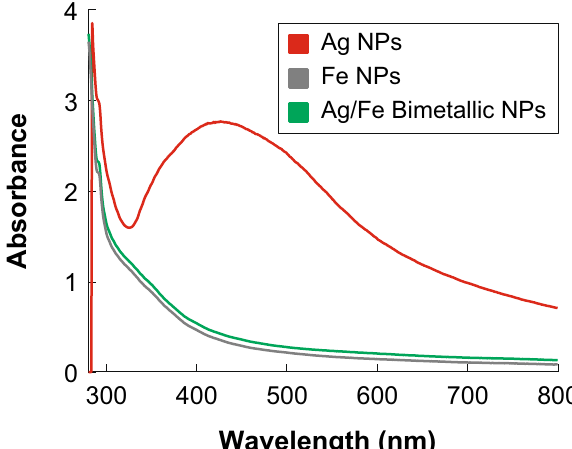
Figure 1. UV–visible absorbance spectra of silver (Ag), iron (Fe) nanoparticles, and Ag–Fe bimetallic nanoparticles synthesized using an aqueous extract from leaves of Gardenia jasminoides .